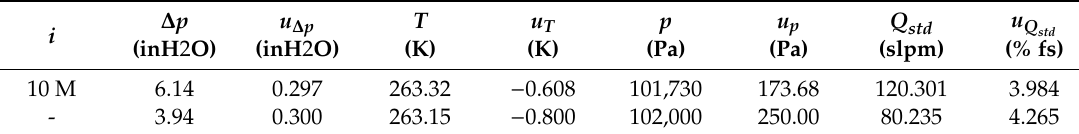
Table 9. Simulation 1: standard volumetric flow rate.